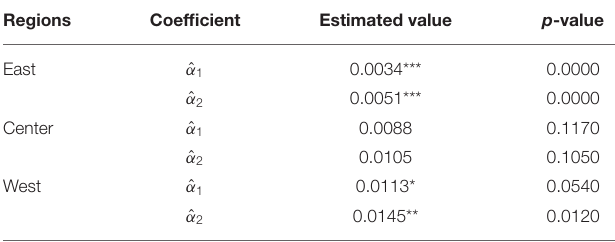
TABLE 4 | Estimated coefficients of urbanization and health care expenditure.